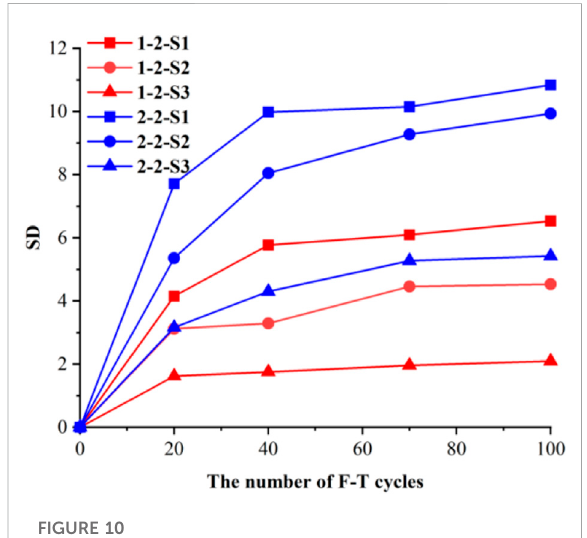
FIGURE 10 SD values for different regions of granite samples under different numbers of F – T